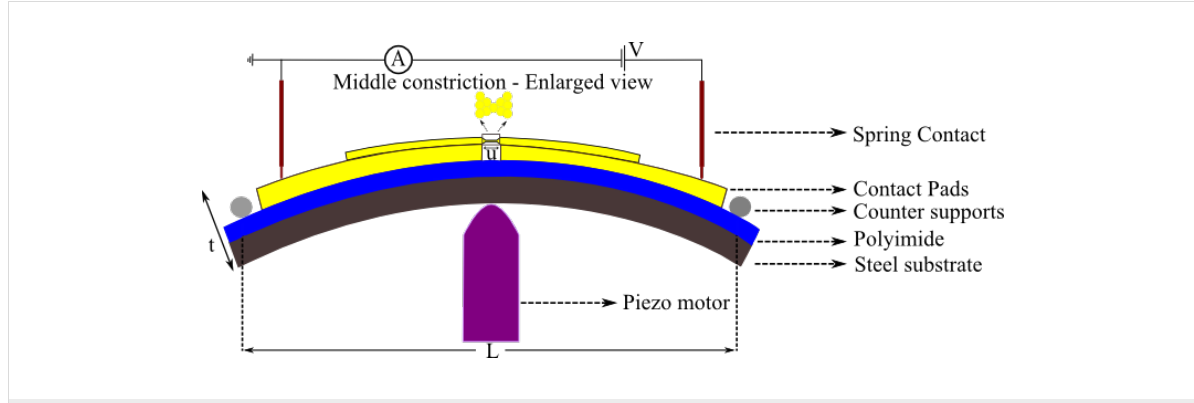
Figure 1: Schematic of our break junction